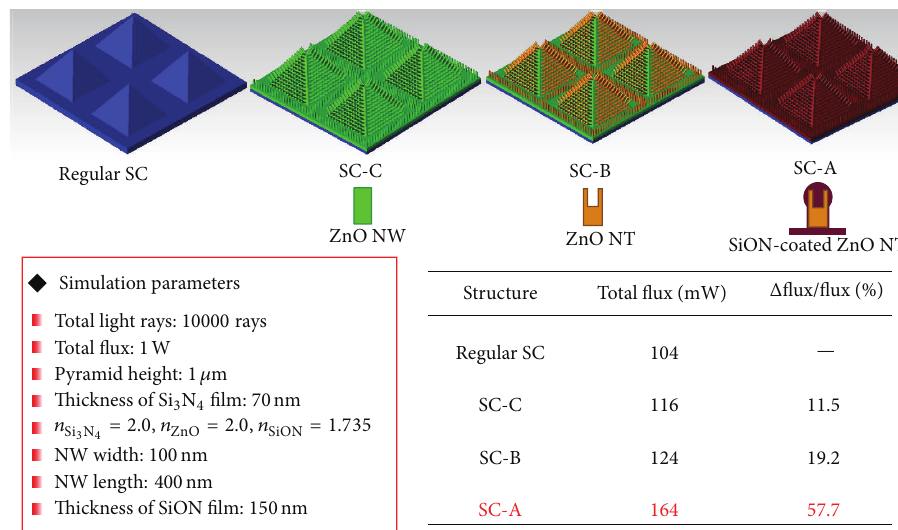
Figure 7: Simulation and calculation results of regular SC, SC-C, SC-B, and